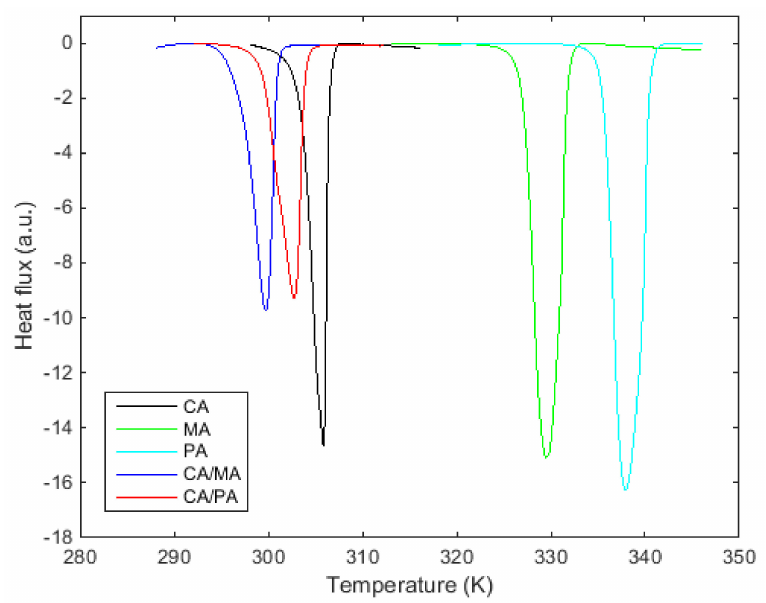
Figure 1. DSC curves of the three pure fatty acids and the two eutectic compositions.